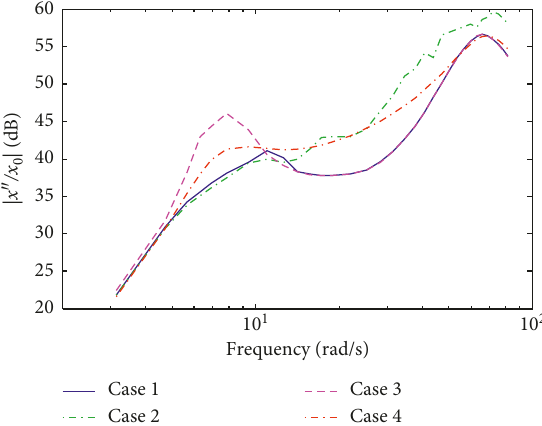
Figure 15: Amplitude-frequency characteristics of “Body vertical acceleration-Road excitation.”